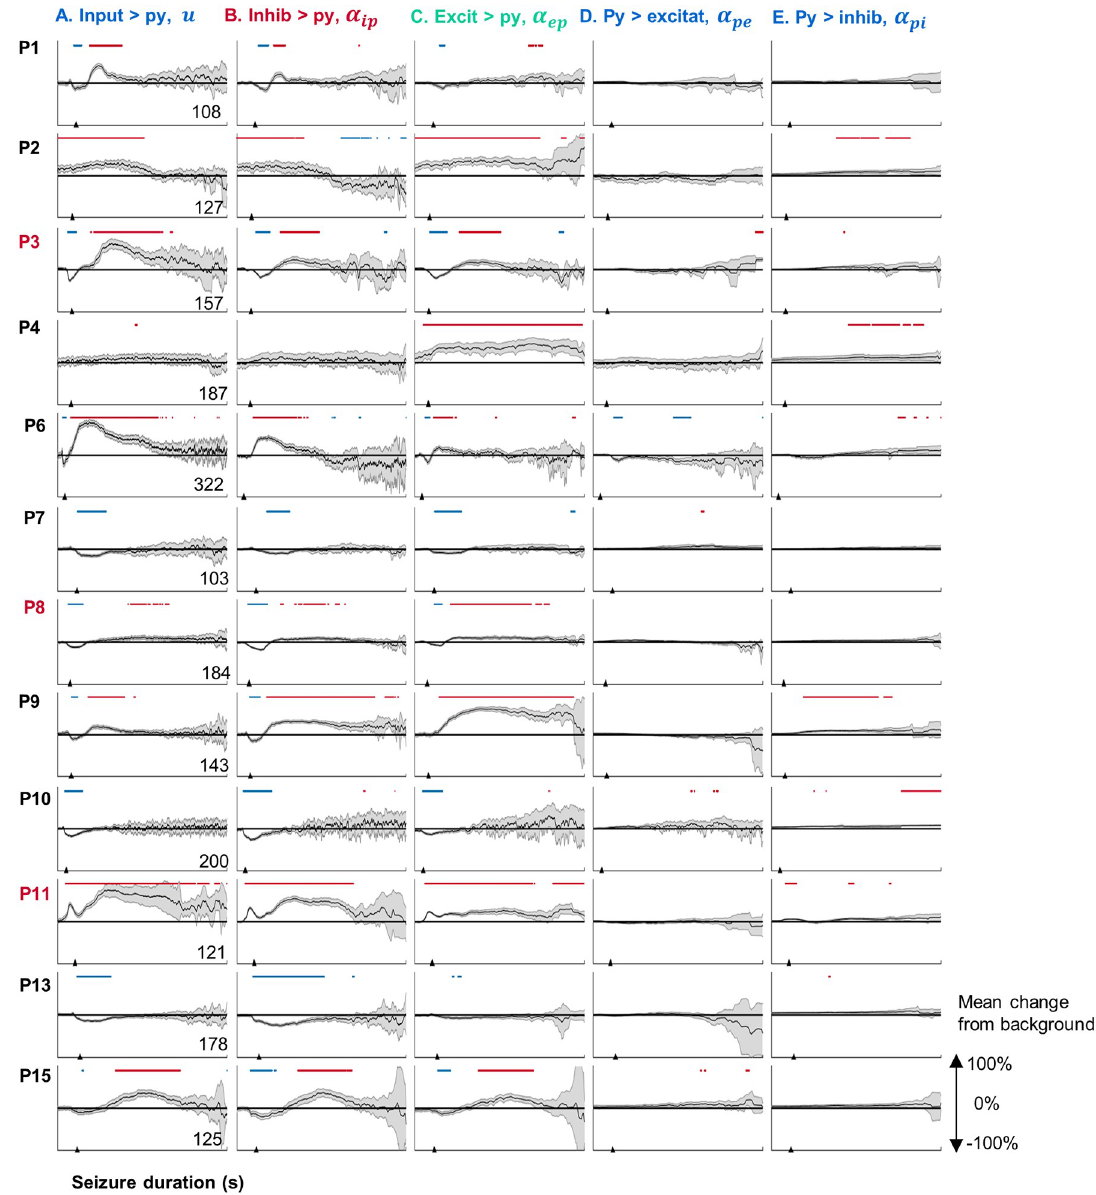
Fig 4. Average changes in parameter trajectories. Each subpanel represents the mean connectivity strength (averaged across seizures) for each patient (grey shading represents the 95% confidence bounds of the mean). For each patient a single representative channel was chosen (P1: Ch3, P2: Ch1, P3: Ch2, P4: Ch2, P6: 7, P7: Ch15, P8: Ch11, P9: Ch4, P10: Ch13, P11: Ch9, P13: Ch5, P15: Ch1). Data for all channels is provided online (https://github.com/pkaroly/Data-Driven-Estimation/tree/master/figures/connectivity). Parameters are expressed as a percentage change from their pre-ictal background values (where zero reflects no change from the pre-ictal period). The pre-ictal period was defined from two minutes to one minute before seizure onset. Significant (p < 0.05) changes are marked in blue (decrease from baseline) and red (increase from baseline) at the top of each plot. Bimodal patients are shown with red labels. Columns from A-E show the connectivity parameters: A) external input to pyramidal neurons, B) inhibitory to pyramidal connectivity, C) excitatory to pyramidal connectivity, D) pyramidal to excitatory connectiviy, E) pyramidal to inhibitory connectiviy.